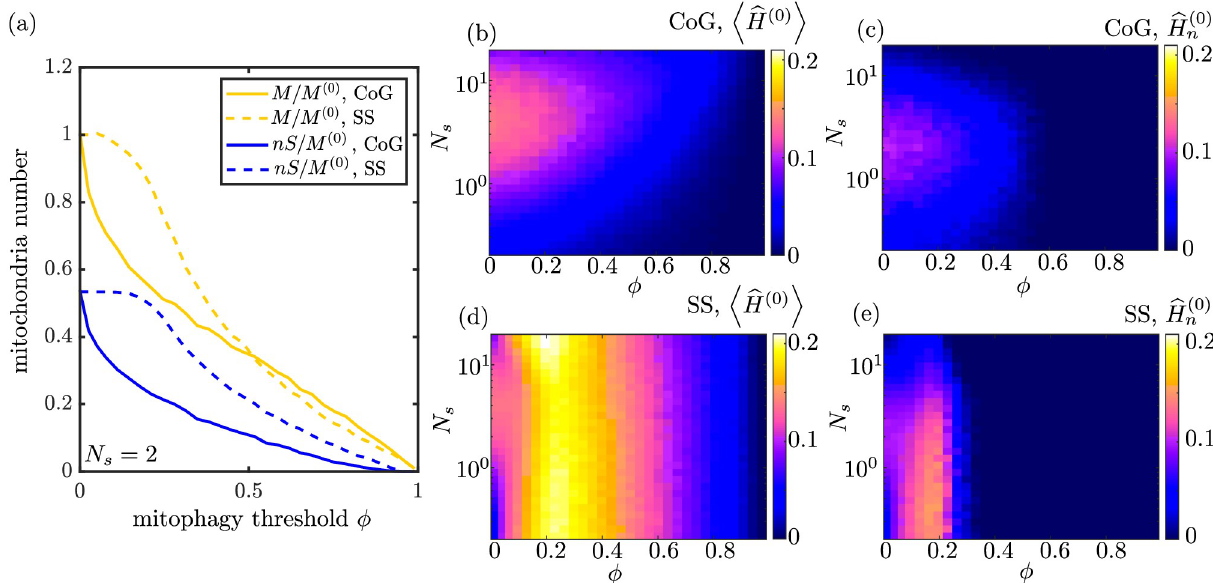
Fig 8. Effect of mitophagy, at fixed production rate k . (a) The total number of mitochondria in the domain (yellow) and the number of stationary p mitochondria (blue) are plotted as a function of the mitophagy threshold, for both the CoG model (solid lines) and the SS model (dashed lines). Mitochondria quantities are normalized by the steady-state number of mitochondria in the absence of mitophagy. (b) Mitochondrial health for the CoG model, averaged over all demand sites, plotted as a function of mitophagy threshold and number of stopping events N s . (c) Health at most distal demand site, for the CoG model. (d-e) Analogous plots of average health and distal site health for the SS model. All plots assume mitochondrial production rate does not change with increased mitophagy, and correspond to fraction of mitochondria stopped f s ( ϕ = 0) = 0.53 in the absence of mitophagy.